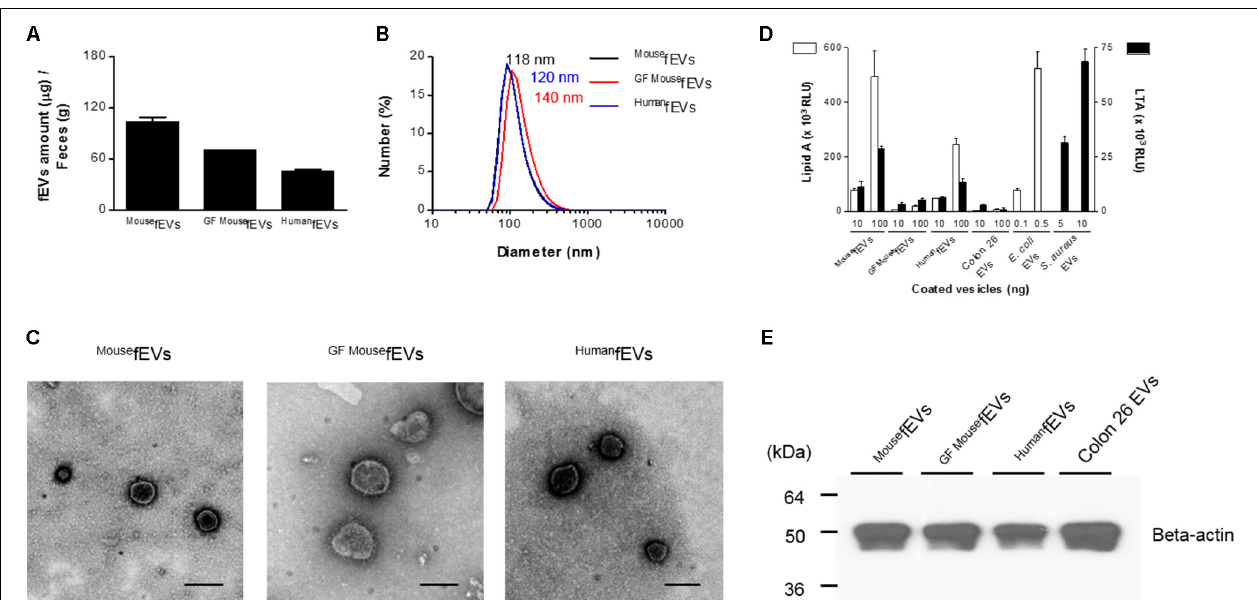
FIGURE 2 | The fEVs originate from intestinal bacteria and the hosts. (A) The yields of fEVs measured in the total protein amounts ( n = 3). (B) The size distribution of the fEVs measured by dynamic light scattering ( n = 5). (C) TEM images of the purified fEVs. Scale bars = 200 nm. (D) The fEVs were analyzed for the content of lipid A (Gram-negative bacterial component) and LTA (Gram-positive bacterial component) by ELISA (RLU, relative luminescence unit) ( n = 3). EVs derived from E. coli , S. aureus , and Colon26 were used as controls for Gram-negative and Gram-positive bacterial as well as host origins, respectively. (E) The fEVs (20 µ g in total protein amounts) were analyzed by Western blot, using anti-beta-actin antibody, and Colon26 EVs (30 µ g in total protein amounts) were used as controls for mouse origins. Error bars indicate